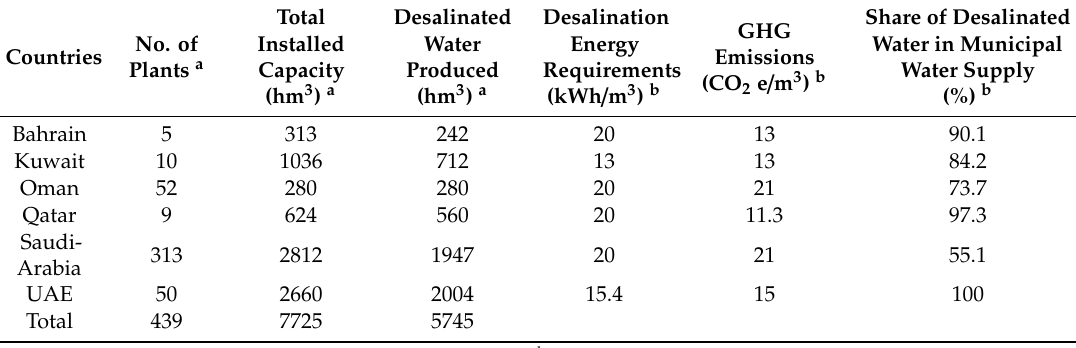
Table 2. Desalinated water capacity, production, and use in the GCC